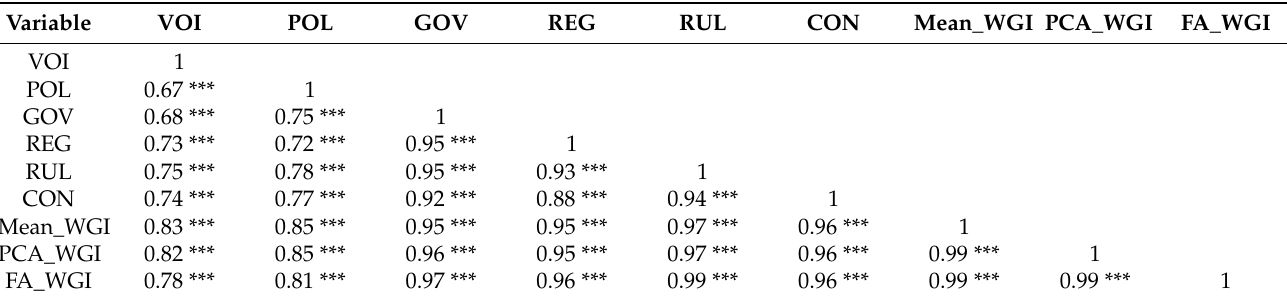
Table 2. Correlation matrix of all six WGI dimensions for 163 sample countries.